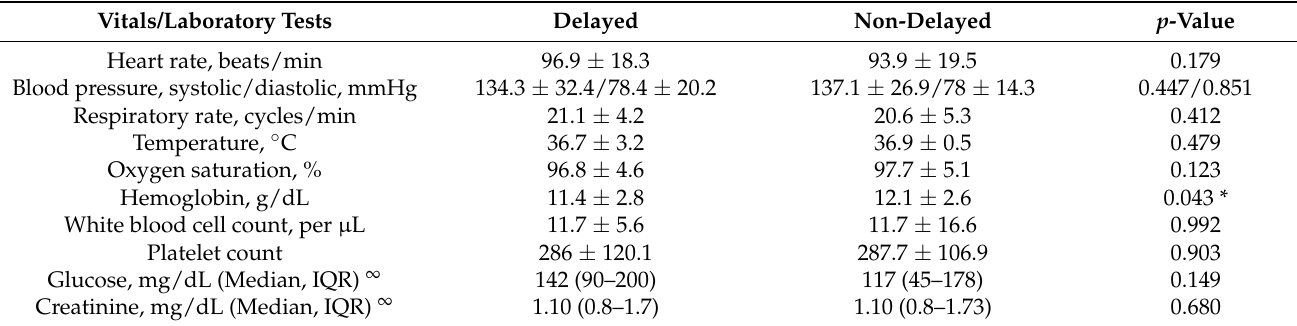
Table 2. Comparisons of vital signs and laboratory test results at the time of admission among the patients who presented to the emergency department.